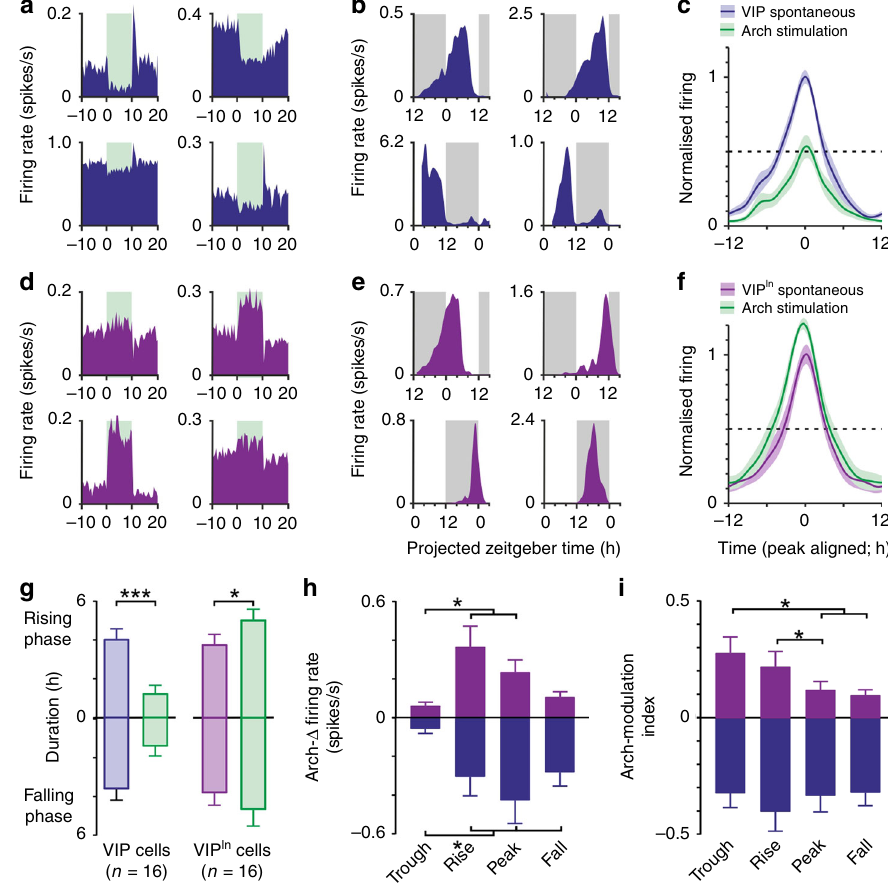
Fig. 5 Optogenetic inhibition of SCN VIP cells modulates daily variations in VIP in cell activity. a , d Peri-event histograms for example SCN VIP ( a ) and extra-SCN VIP in ( d ) cells identi fi ed in pMEA recordings from VIP-Arch slices by 10s yellow light steps applied to the SCN region (565 nm, 140 mW/mm 2 at fi bre tip; means of ~300 trials). b , e Example spontaneous fi ring activity from optogenetically identi fi ed SCN VIP ( b ) and extra-SCN VIP in cells ( e ), from slices prepared during late (top panels) or early (bottom panels) projected day (traces correspond to units in a , d ). c , f Mean ± SEM normalised, peak aligned, 24 h fi ring pro fi les of SCN VIP ( c ) and extra-SCN VIP in neurons ( f ) under baseline conditions and during Arch activation. g Mean ± SEM durations of rising and falling phase of the daily peak (time to <half-max) for SCN VIP and extra-SCN VIP in neurons under baseline conditions and during Arch activation. Data for each class was analysed by multilevel mixed-effects linear model (VIP cells — Arch effect: F 1,43.72 = 32.94, P > 0.001; Rising vs. falling phase: F 1,4.761 = 0.03, P = 0.86; Interaction: F 1,43.72 = 0.47, P = 0.50; VIP in cells — Arch effect: F 1,36.58 = 5.77, P = 0.02; Rising vs. falling phase: F 1,18.72 = 0.004, P = 0.95; Interaction: F 1,36.58 = 0.22, P = 0.64). h , i Mean± SEM Arch-driven change in fi ring rate ( h ) and fi ring rate modulation ( i ; (Arch- spontaneous)/(Arch + spontaneous)) for SCN VIP (blue) and extra-SCN VIP in (purple) neurons across different quartiles of the cells ’ daily fi ring rhythm. In both cases data for each class analysed by multilevel mixed-effects linear model ( h VIP cells: F 3,38.66 = 7.26, P = 0.001; VIP in cells: F 3,21.88 = 5.68, P = 0.005; i VIP cells: F 3,15.05 = 0.30, P = 0.88; VIP in cells: F 3,139.99 = 4.67, P = 0.004).Tukey ’ s post-tests were applied where ANOVA reported a signi fi cant effect; * P < 0.05, *** P <